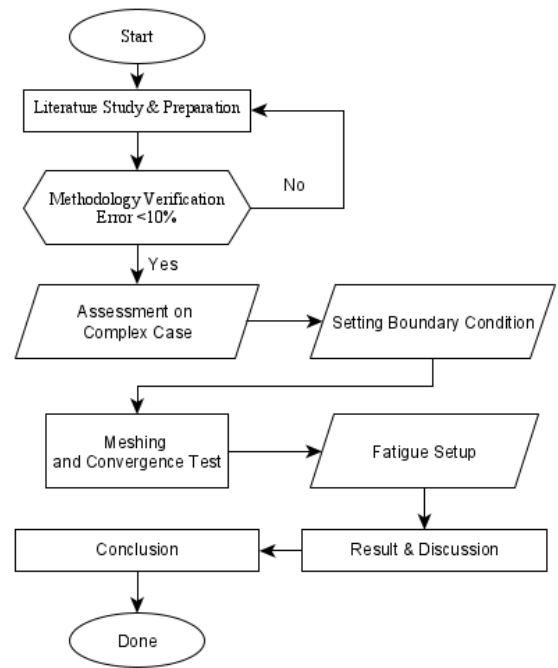
Figure 3. Research Scheme Figure 3: Research